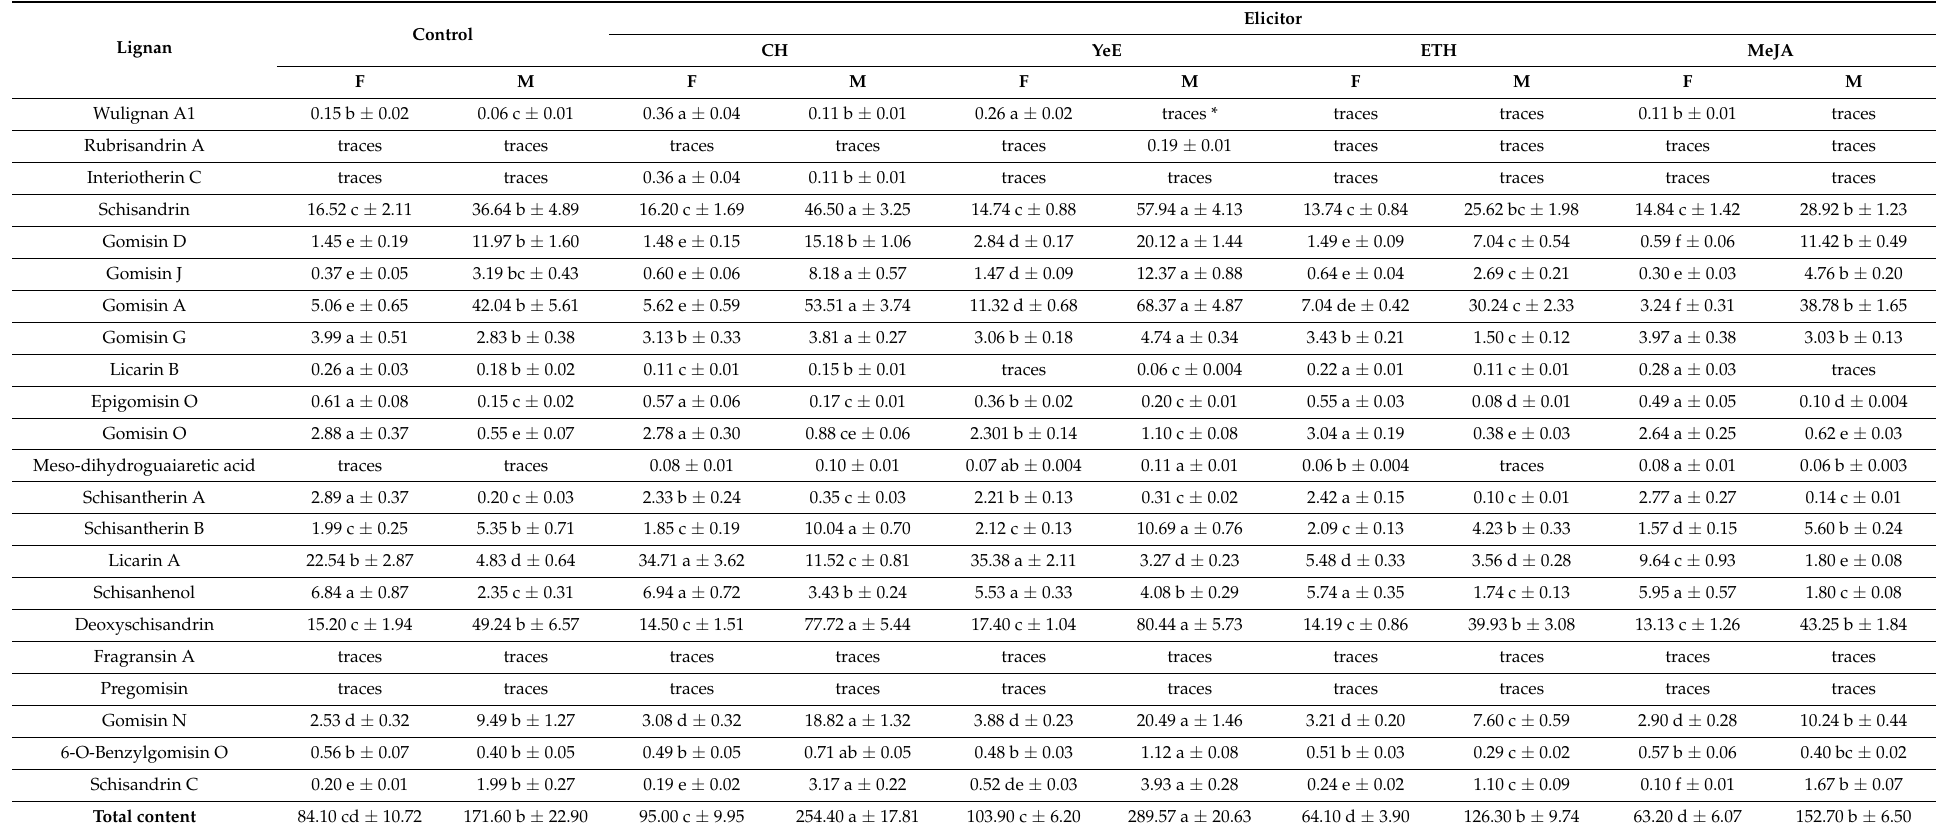
Table 5. Accumulation of lignans (mg/100 g DW) in agitated cultures of S. rubriflora lines F and M 6 days after addition of elicitor. Data expressed as the